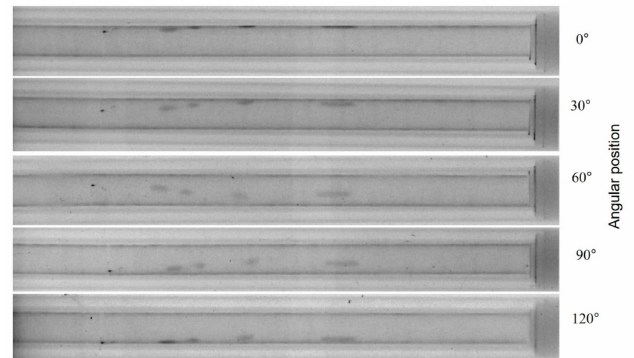
Figure 7. A fuel cladding tube at different rotation angles; darker areas showing the higher local hydrogen content in the cladding. The outer diameter of the cylindrical tubes is approximately 10